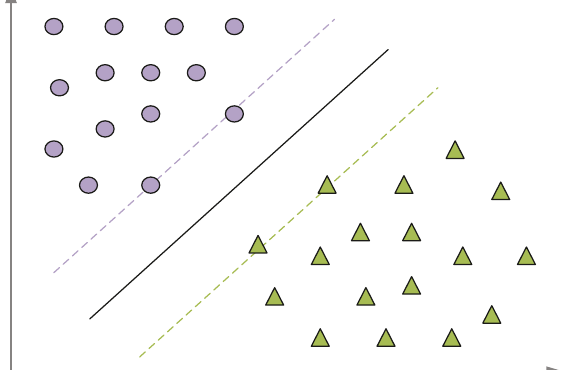
Figure 2: Support vector machine.